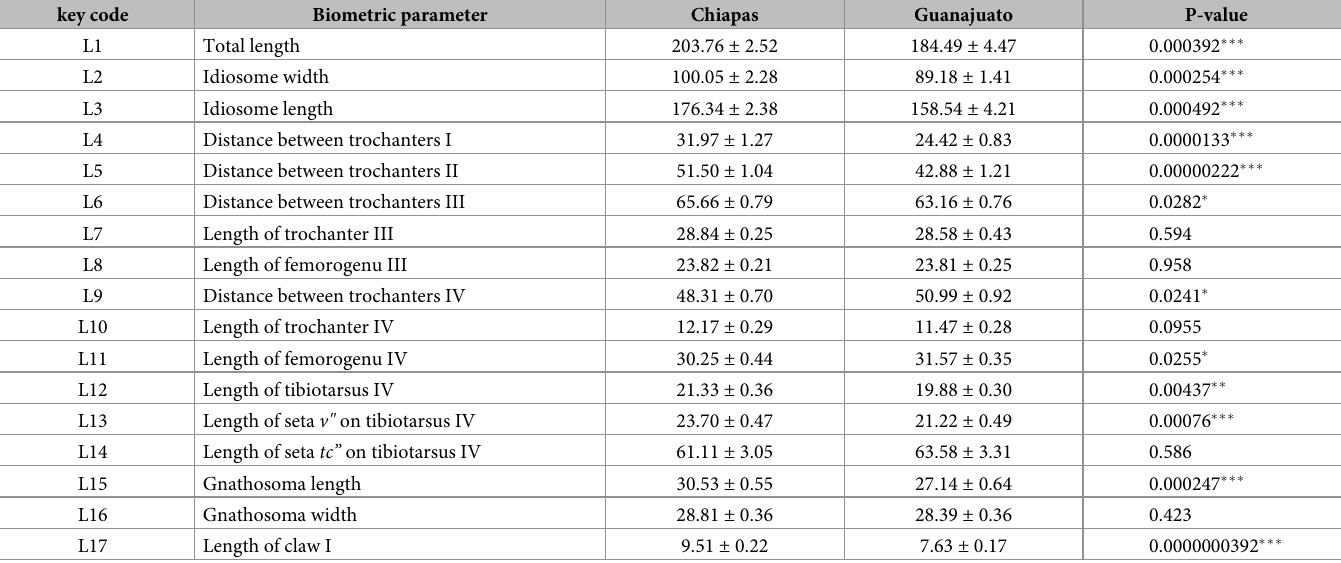
Table 2. Comparison of averages of biometric parameters in female specimens of Polyphagotarsonemus latus collected in Chiapas and Guanajuato.